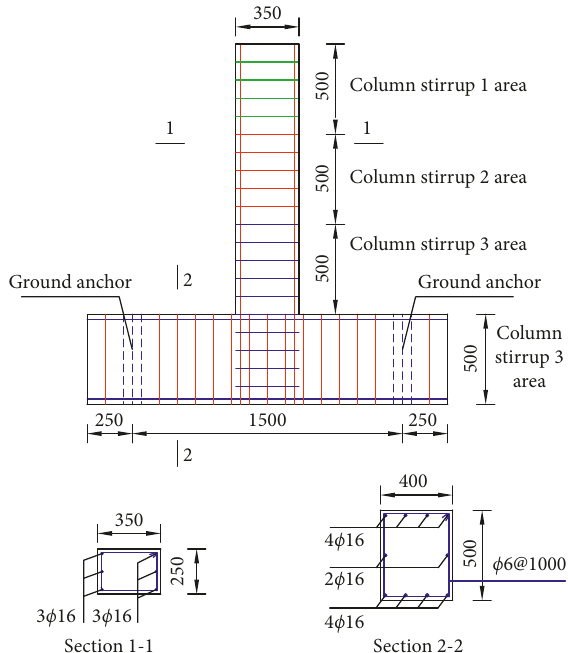
Figure 1: Size and reinforcement of the first group of test members.